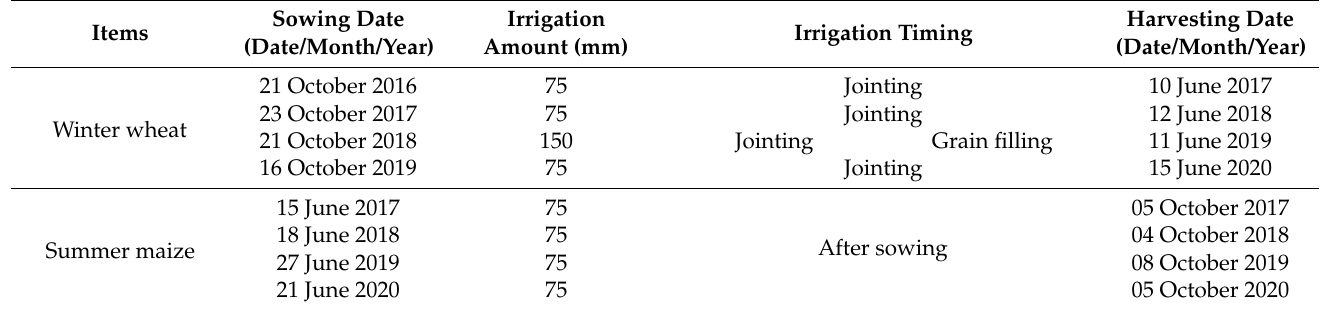
Table 2. Sowing and harvesting date, and irrigation timing and amounts for all treatments